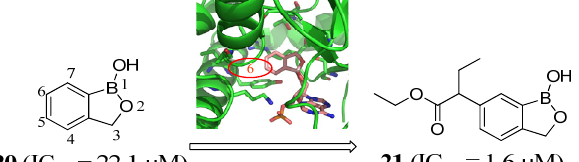
Figure 8. Inhibitor design scheme of Ding et al. (2011) for LeuRS. LeuRS is in cartoon representation and colored green, while compound 20 is in stick conformation and is colored salmon